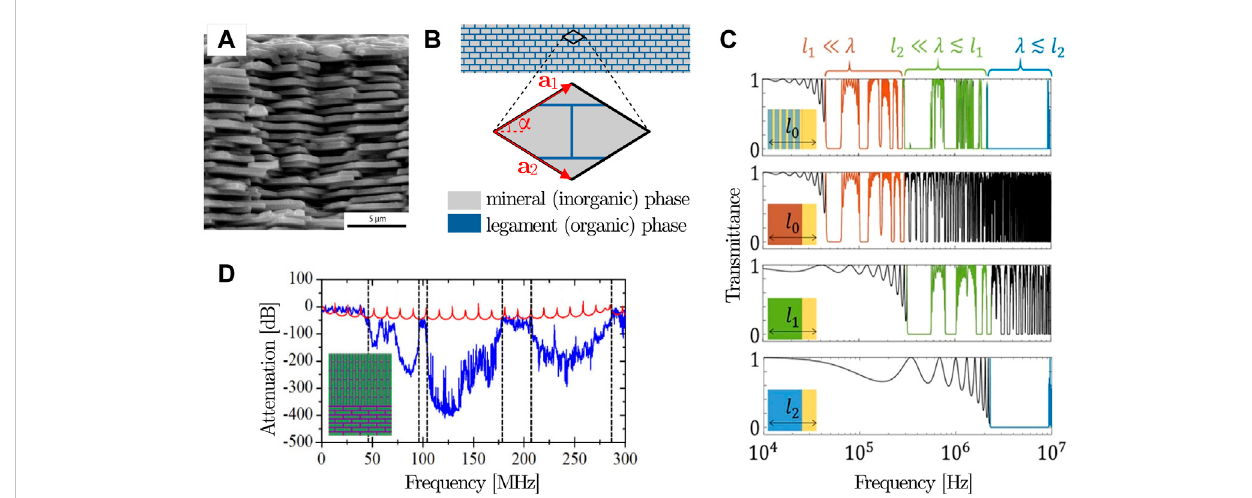
FIGURE 3 NacrestructureandassociatedbioinspiredPCapplications. (A) Cross-sectionofnacreshowingthebrick-and-mortarmicrostructure[adaptedfrom (Ferrand,2022)]. (B) Exampleofabrick-and-mortarperiodicstructurewithaninsetrepresentingthehexagonallatticeunitcell(angle α betweenthebasis vectors) with both inorganic (hard, in grey) and organic (soft, in blue) phases. (C) Transmittance pro fi le for a hierarchical PC ( fi rst row) and corresponding homogenized structures (second to fourth rows), with l 0 ≫ l 1 ≫ l 2 [adapted from (Lee and Jeon, 2020)]. (D) Attenuation relative to a fi nite structure obtained by combining lattices with different orientations [adapted from (Chen and Wang,